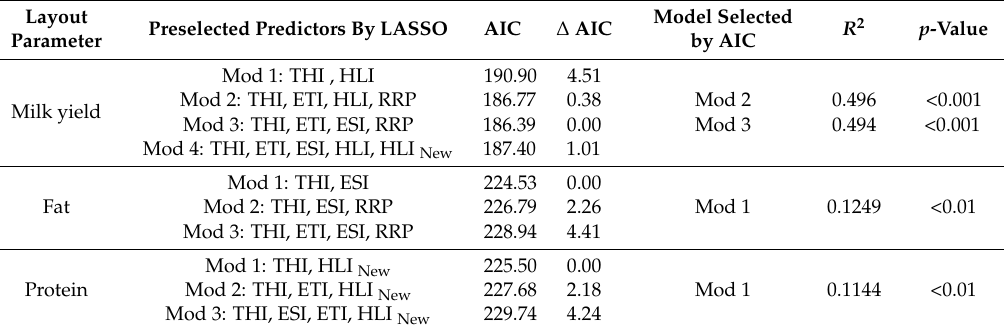
Table 5. Results of LASSO and Akaike Information Criterion (AIC) analysis for finding the best multiple regression model between milk parameters and climatic indices in spring. Mod1 to Mod4 in “Milk yield” refers to the dashed lines in Figure 4a; Mod1 to Mod3 in “Fat” refers to Figure 4b, and Mod1 to Mod3 in “Protein” refers to Figure 4c.